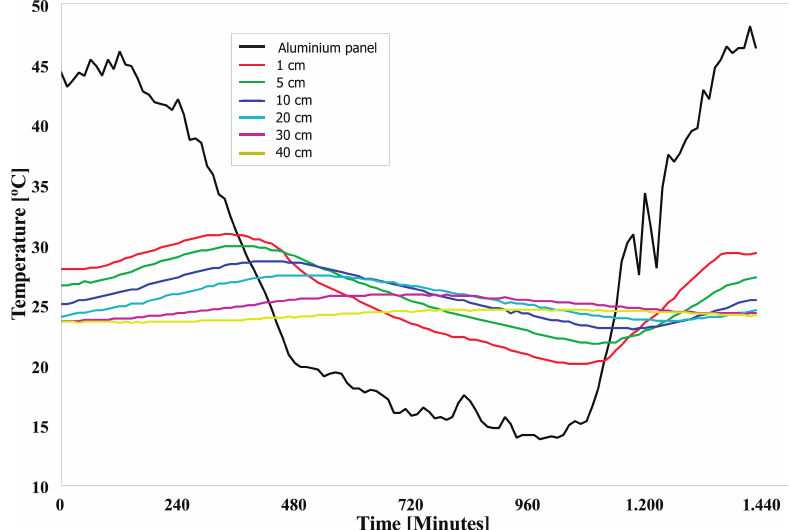
Figure 7. Measured temperature at various depths, during one sunny day in the winter (21 July 2015) in